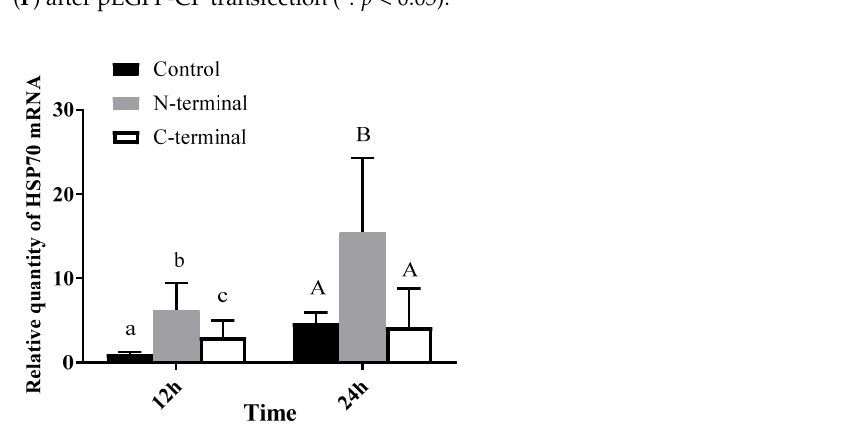
Figure 6. mRNA expression level of HSP70 after pEGFP-CP-N (N-terminal) or pEGFP-CP-C (C- terminal) transfection. Different letters represent significant differences between groups ( p <